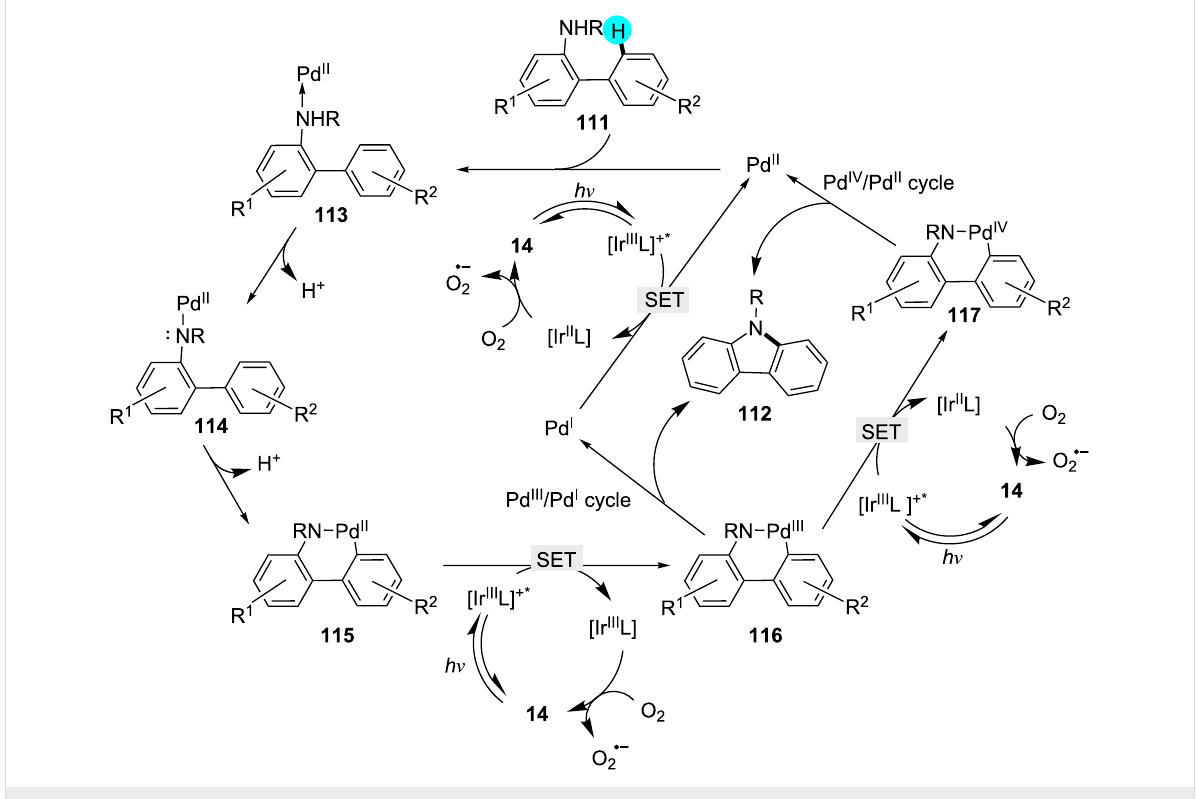
Figure 18: Proposed mechanism for the formation of carbazoles from biaryl derivatives.